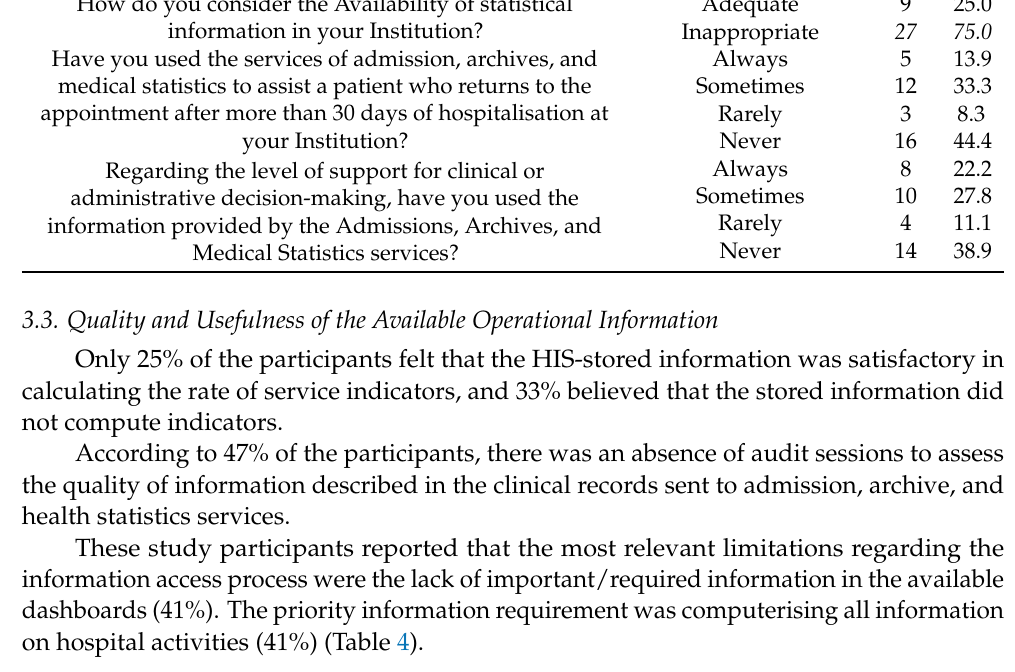
Table 4. HIS: quality and usefulness of the available operational information ( n =